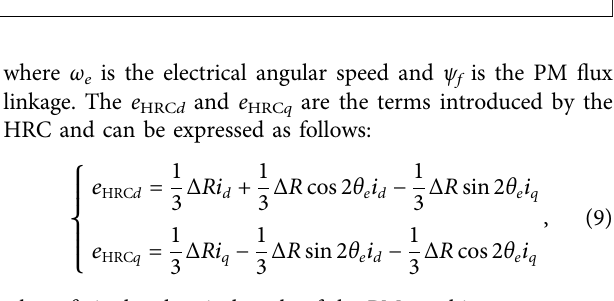
FIGURE 3 | Dq -axis decoupling of the PM machine with